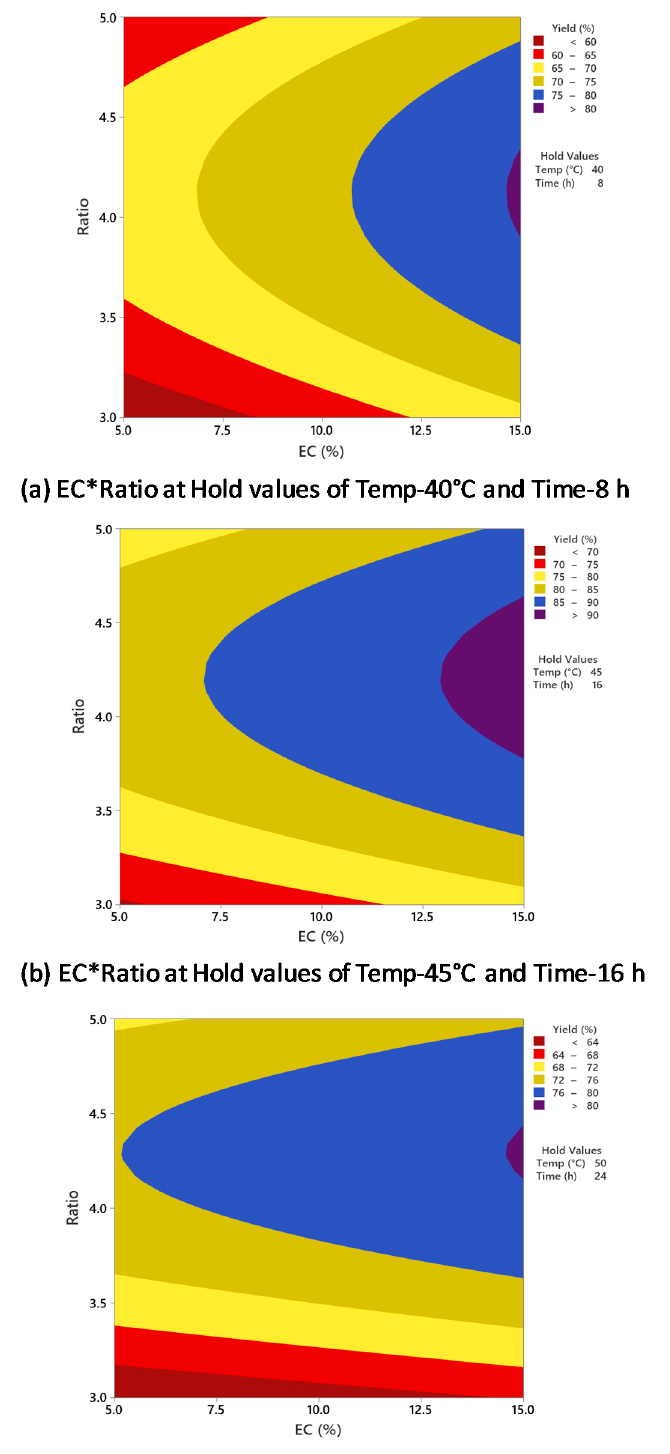
Figure 7. Counterplots of yield vs. enzyme concentration and oil/alcohol ratio at ( a ) 40 ◦ C and 8 h; ( b ) 45 ◦ C and 16 h; ( c ) 50 ◦ C and 24